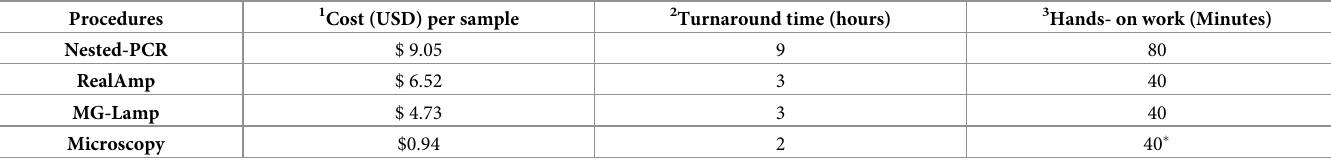
Table 3. Cost and turnaround time of LAMP assays compared with nested-PCR and Microscopy.